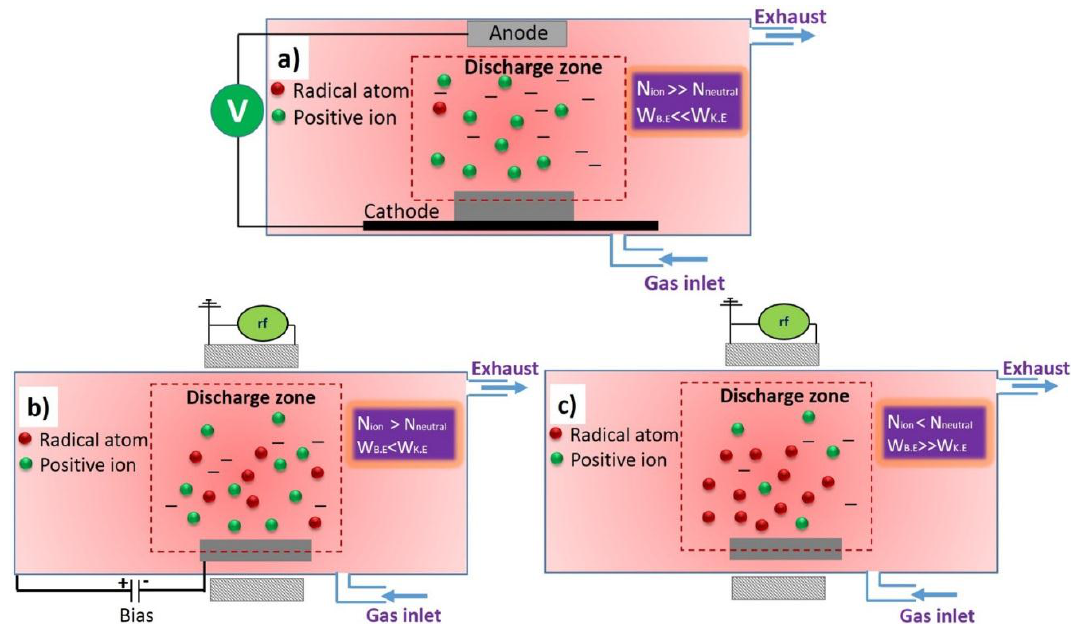
Figure 2. Schematic representation of various plasma processing systems for ( a ) sputtering; ( b ) reactive ion etching; and ( c ) highly dissociated weakly ionized plasma for chemical etching.